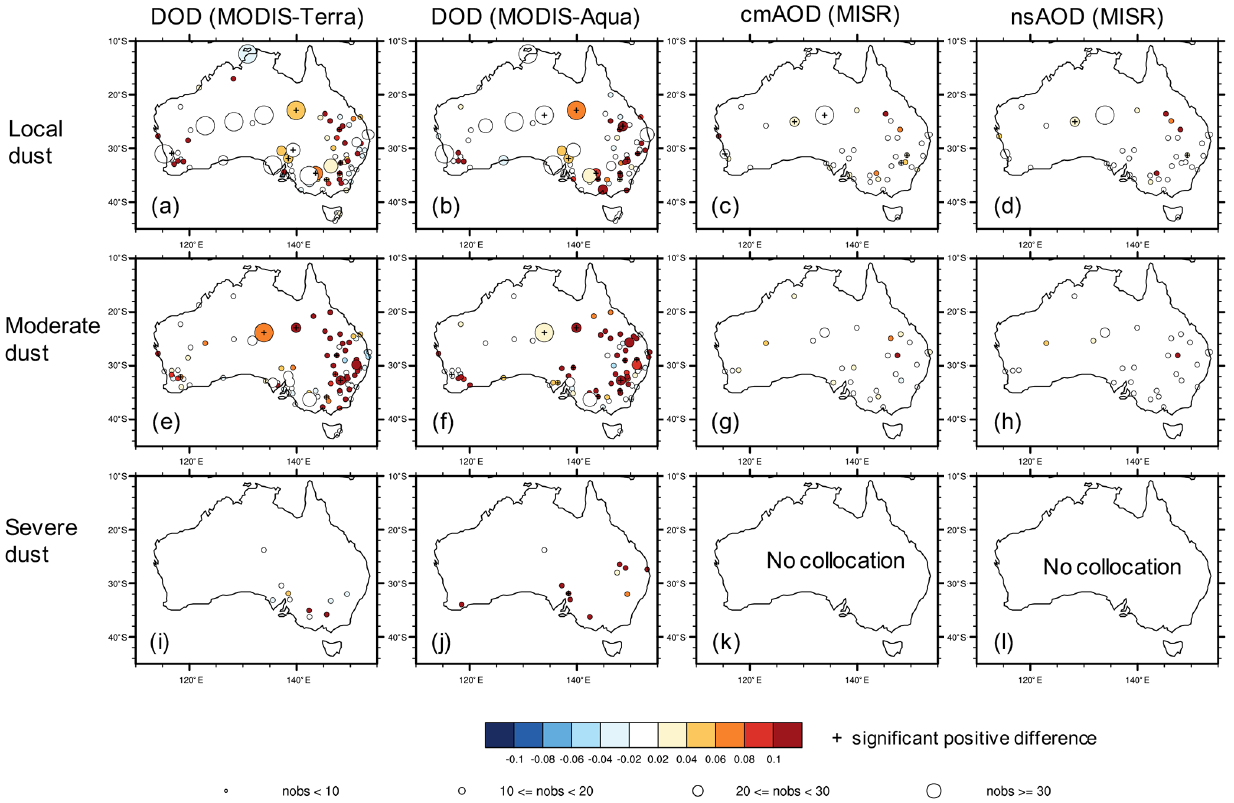
Figure 8. Difference in satellite DOD proxies between dusty days and clear days at weather stations in Australia. The color of the filled dots represents the difference in (a, e, i) DOD from MODIS-Terra, (b, f, j) DOD from MODIS-Aqua, (c, g, k) cmAOD from MISR, and (d, h, i) nsAOD from MISR between days with no reported dust observation and days with reported (a–d) ”local dust”, (e–h) ”moderate dust”, and (i–l) “severe dust”. The size of the dots indicates number of days with both weather observations and valid satellite retrievals within 25km at each station. A plus sign indicates a significant positive difference in DOD between dusty and clear days based on a Monte Carlo bootstrap test ( p < 0 .